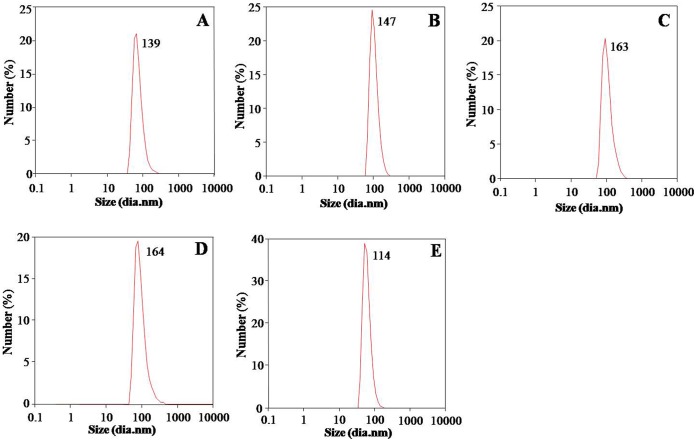
Size measurements of PLA NPs with DLS.(A) PLA-1 (B) PLA-2 (C) PLA-3 (D) PLA-4 (E) PLA-5. One ml of each PEs synthesized PLA NPs was taken in disposable sizing cuvette cells for recording size on DLS.